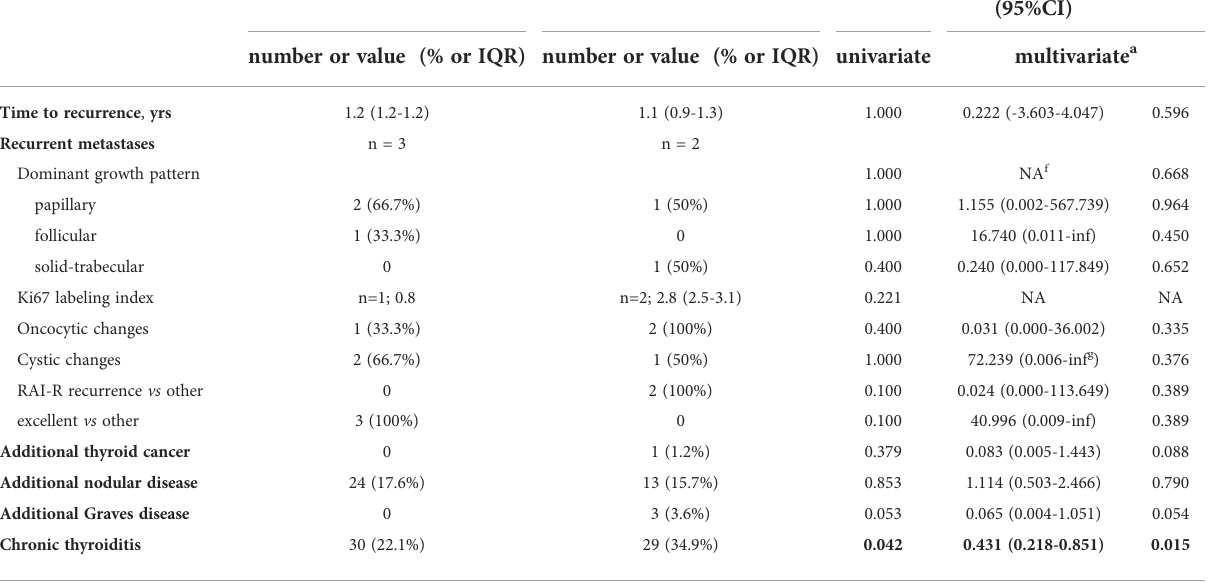
(Table 4) displayed practically no differences between the baseline, histopathological and clinical characteristics except for the less frequent central lymph node dissection (OR = 0.163, p = 0.031) in, and longer follow-up period (OR = 1.935, p = 0.001) of patients with radiogenic